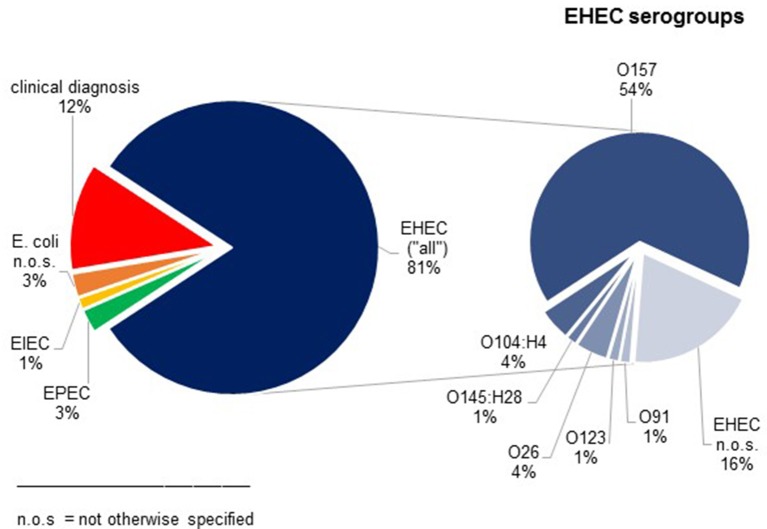
Results of microbiological analysis in patients with STEC-HUS. In 12% clinical diagnosis of STEC-HUS was suspected without detection of E. coli.